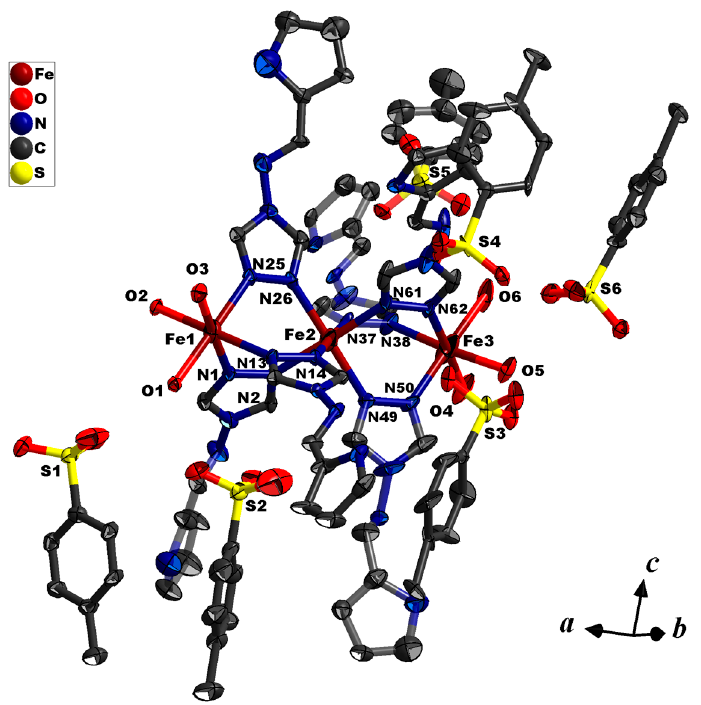
Figure 5. Thermal ellipsoid view of the linear trinuclear complex C2 at 173 K, shown with 40% probability ellipsoids. All water, methanol solvent molecules and H atoms are omitted for clarity, and only selected atoms are labelled.